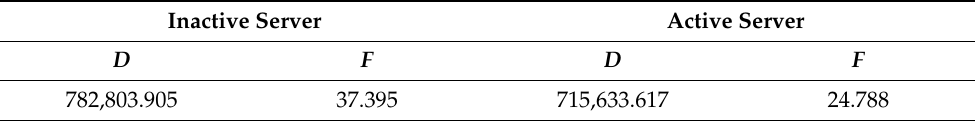
Table 3. Darcy and Forchheimer coefficients for inactive and active servers.